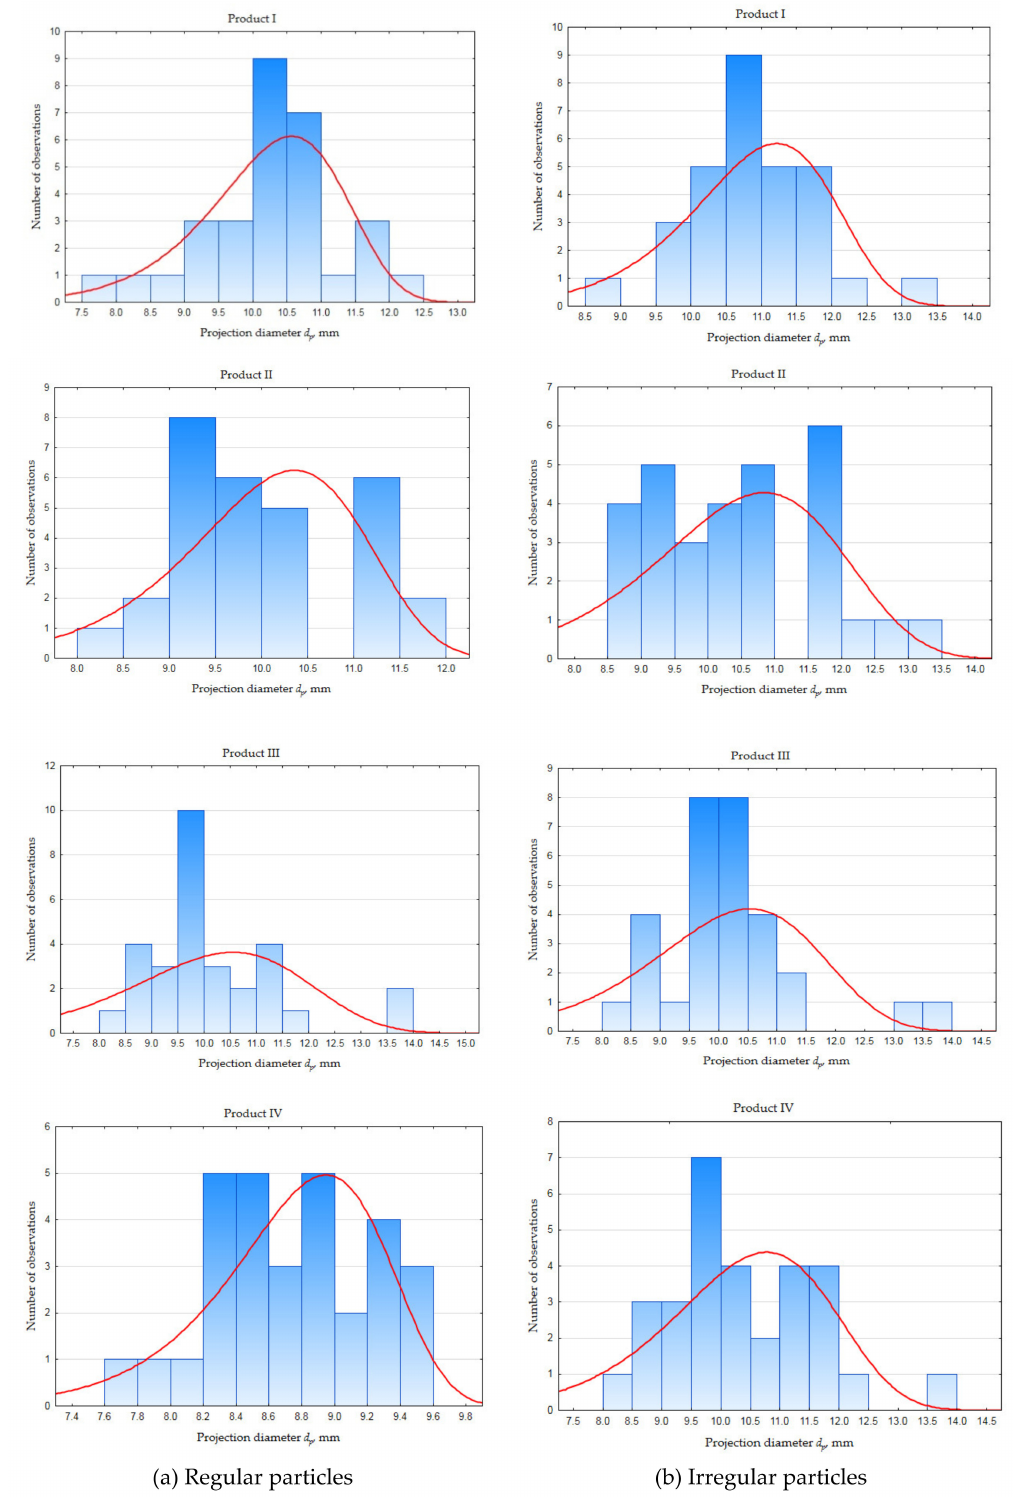
Figure 5. Histograms of the distribution of the projection diameter of the regular and irregular particles separated into four